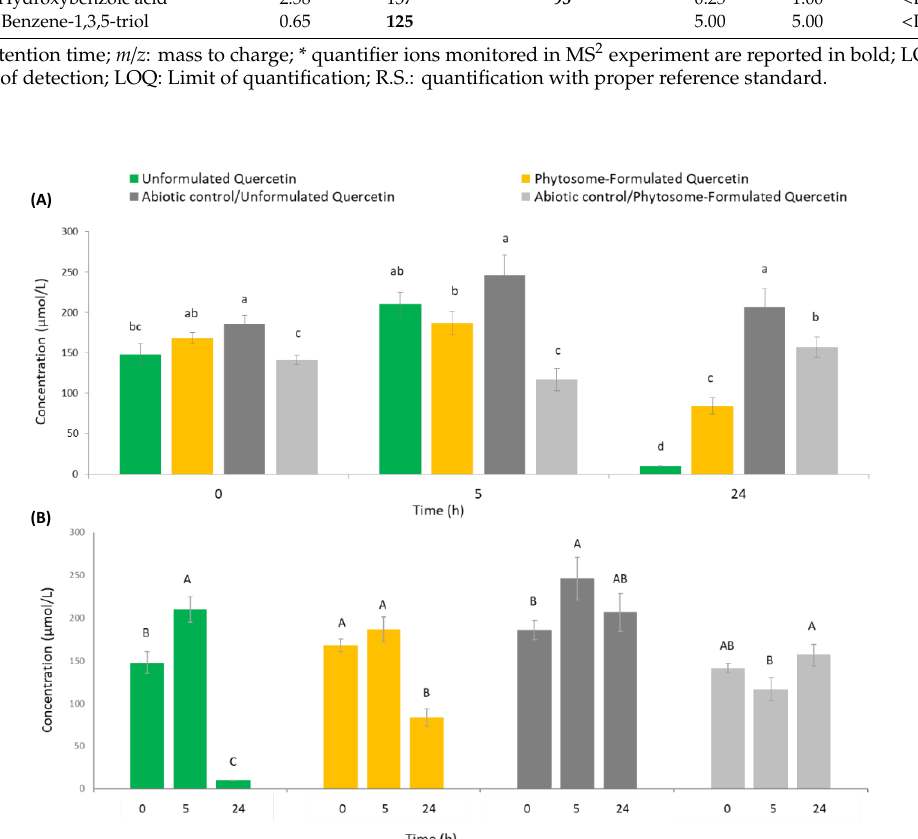
RT: retention time; m / z : mass to charge; * quantifier ions monitored in MS 2 experiment are reported in bold; LOD: Limit of detection; LOQ: Limit of quantification; R.S.: quantification with proper reference standard.